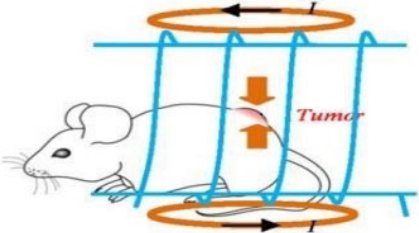
Figure 1. Tumor heating in magnetic field [15].